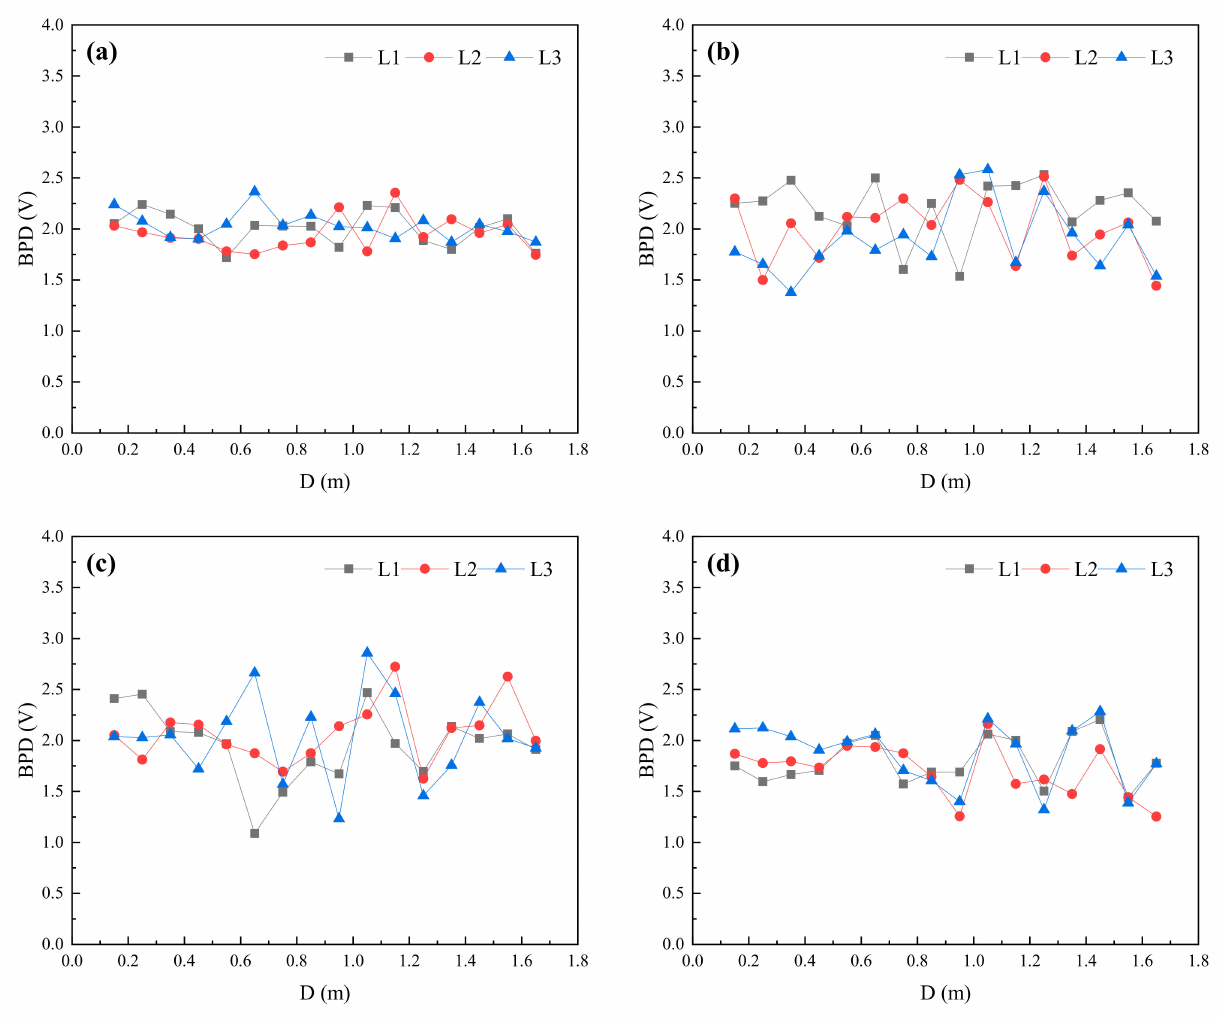
Figure 6. BPD for the different dam models. ( a ) DM 1; ( b ) DM 2; ( c ) DM 3; ( d ) DM 4. The D refers to the distance to dam crest along the downstream slope. The black square symbols, the red circle symbols, and the blue triangle symbols represent the BPD for survey lines LI, L2, and L3,